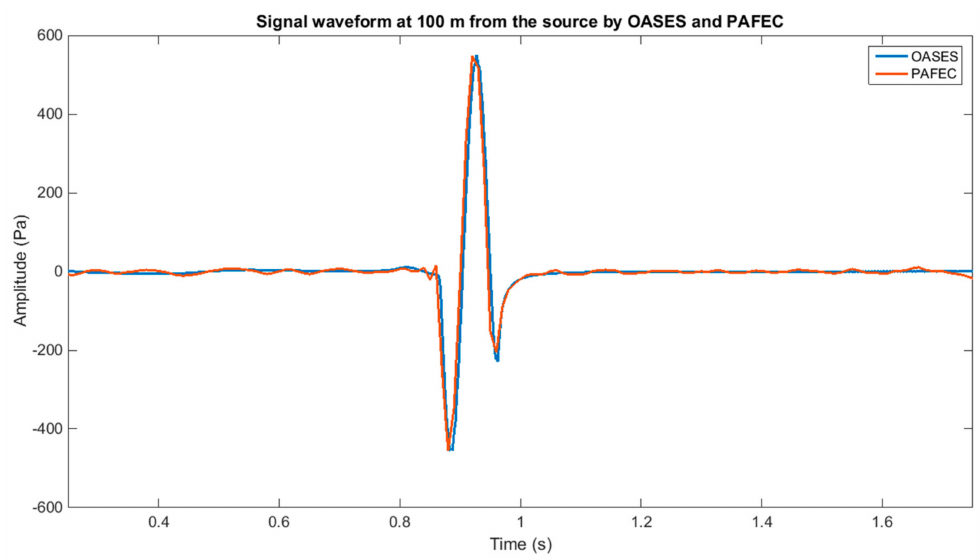
Figure 5. Signal waveform at 100 m radius compared (OASES versus PAFEC).